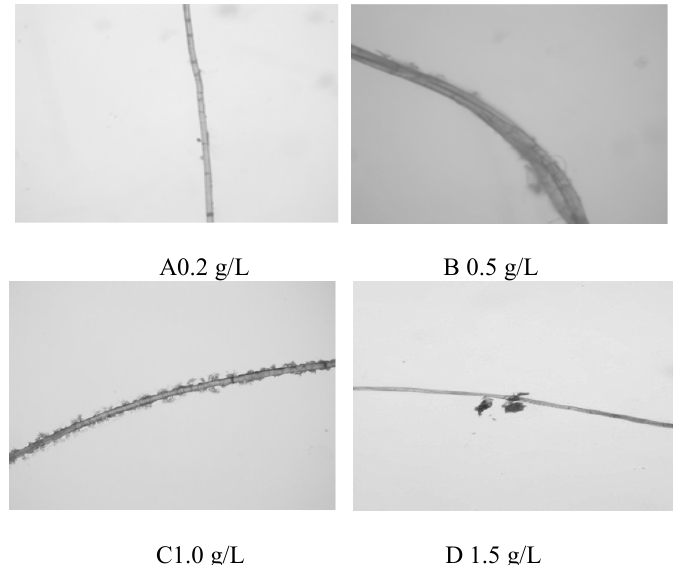
Figure 1. Morphology of PBO fibers after echting.